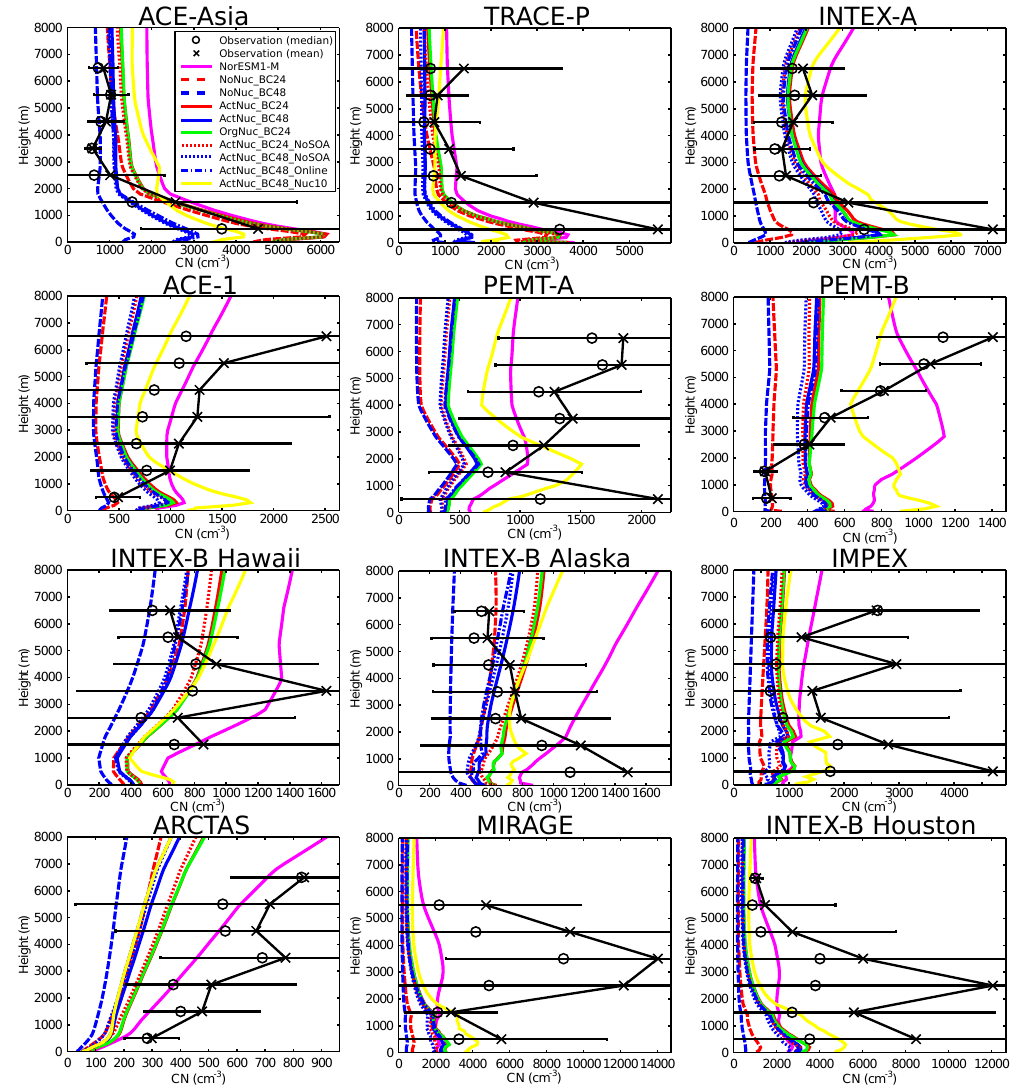
Figure 12. Comparison of NorESM aerosol number concentrations against flight observations compiled by Clarke and Kapustin (2010). The observed mean values (black crosses) are surrounded by one standard deviation, and observed median value is denoted by black circles. Line colouring is explained in legend in top-left